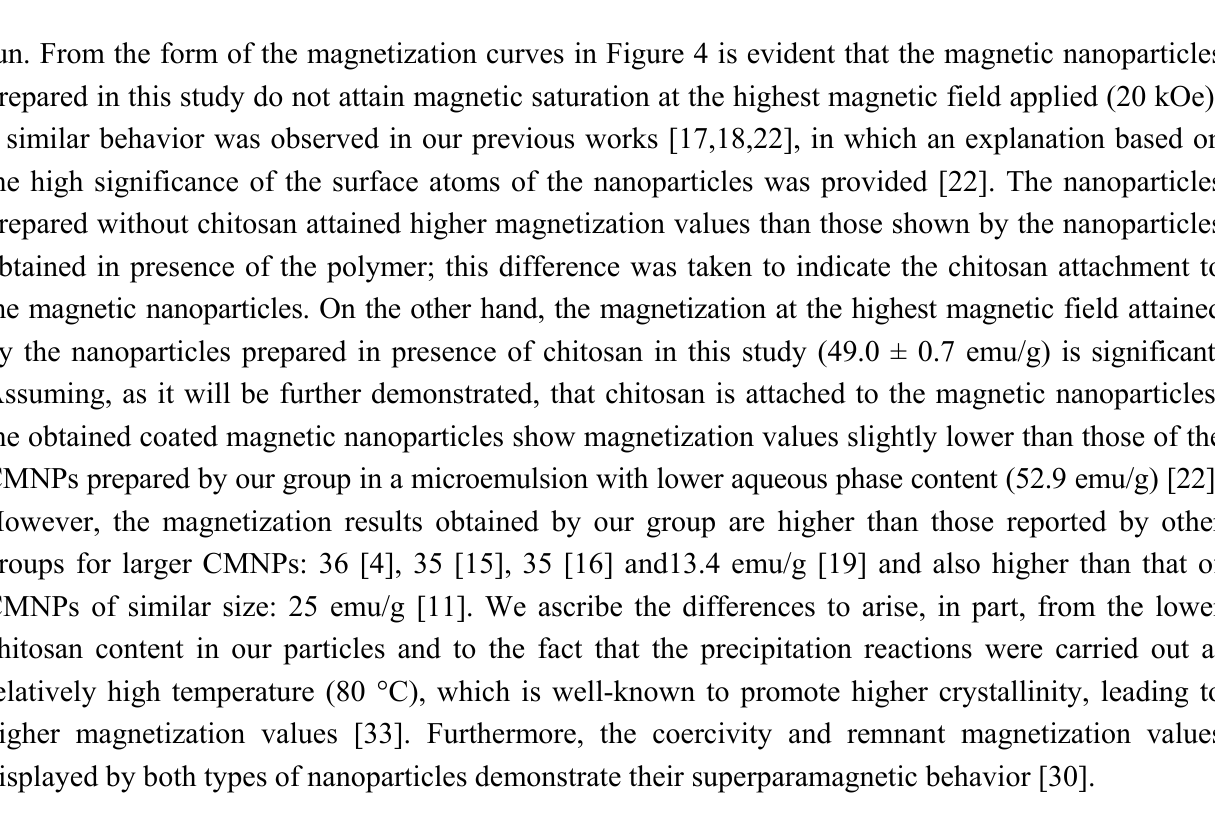
Figure 4. Magnetization curves at room temperature of ( □ ) naked magnetic nanoparticles (MH80) and ( ○ ) chitosan-coated magnetic nanoparticles